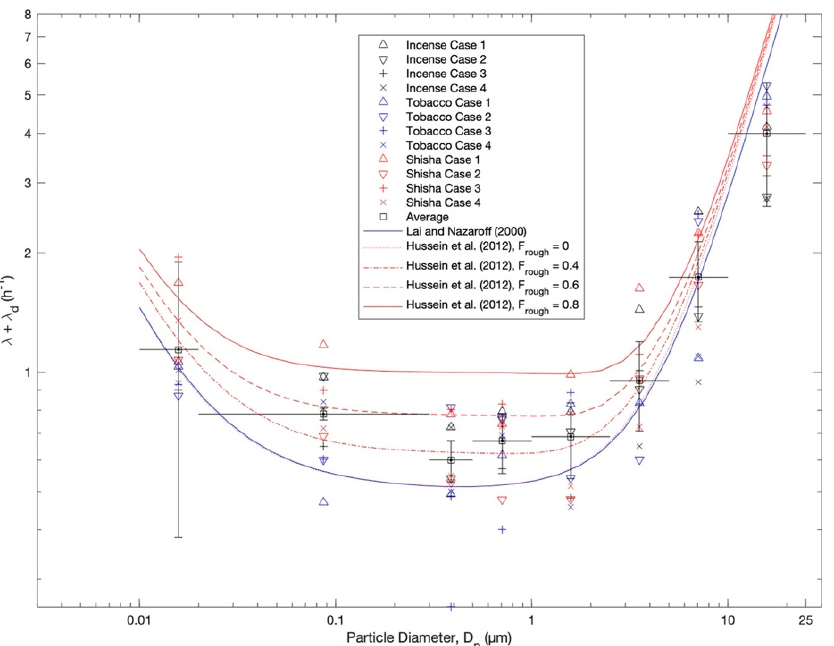
Figure 5. Total particle losses of aerosol particles calculated for each scenario compared to the three- layer model calculations by Lai and Nazaroff [151] for smooth surfaces and Hussein et al. [152] for rough surfaces. The model calculation was made for a room (5 × 2.7 × 2.7 m 3 ), friction velocity u* = 10 cm/s, and ventilation rate λ = 0.5 h − 1 . The surface roughness parameter ( F rough ) is zero for a smooth surface.